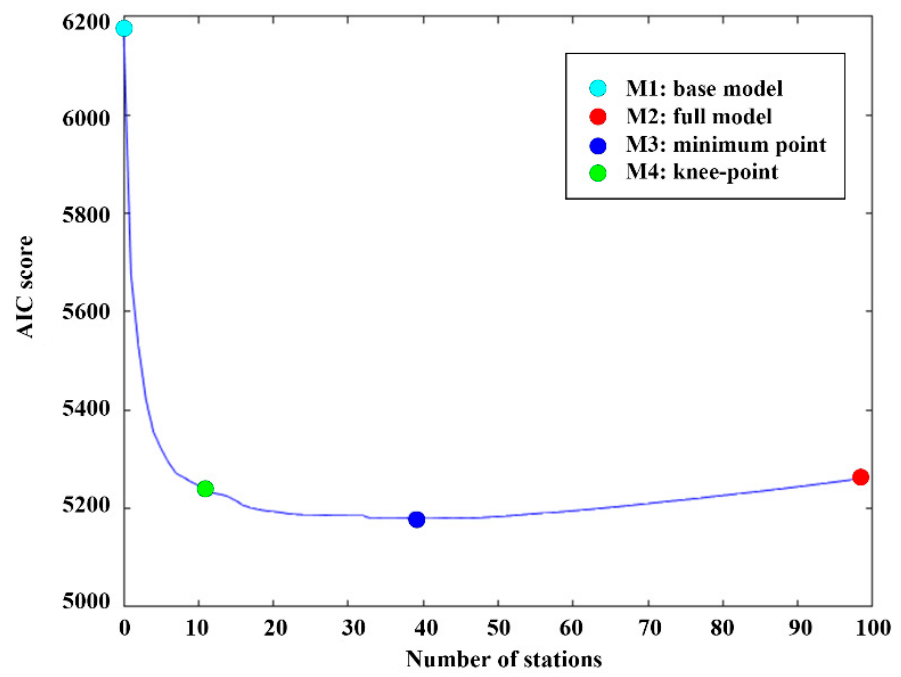
Figure 7. An example of knee-point and minimum point plot.